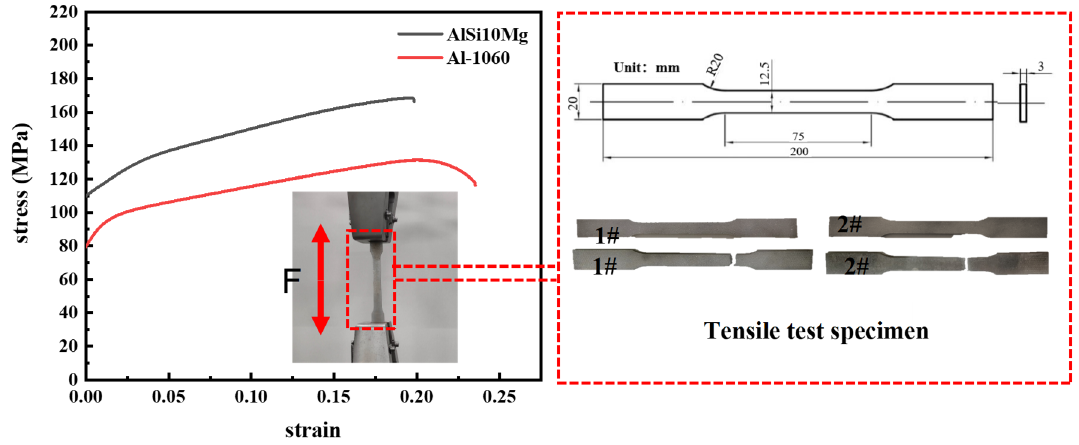
Figure 4. True stress–strain curves of the materials.